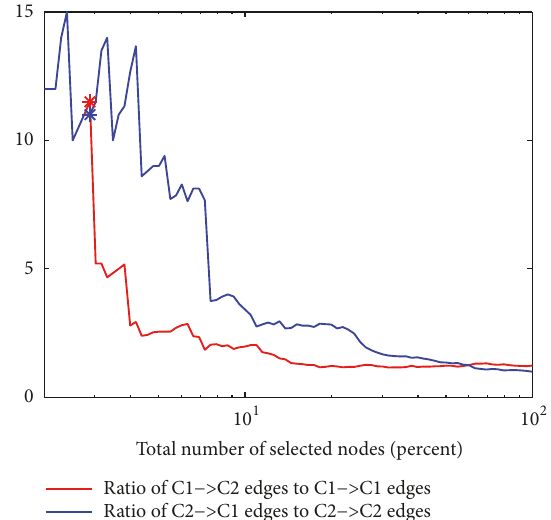
Figure 14: The ratio of the number of edges going from cluster X to cluster Y to the number of edges inside cluster X depending on the percentage of nodes in all clusters for Wikipedia who-votes-on- whom network. Cluster X can be clusterC1 or clusterC2 and cluster Y can be clusterC1 or clusterC2. The asterisk shows the point where the sum of two ratios is the